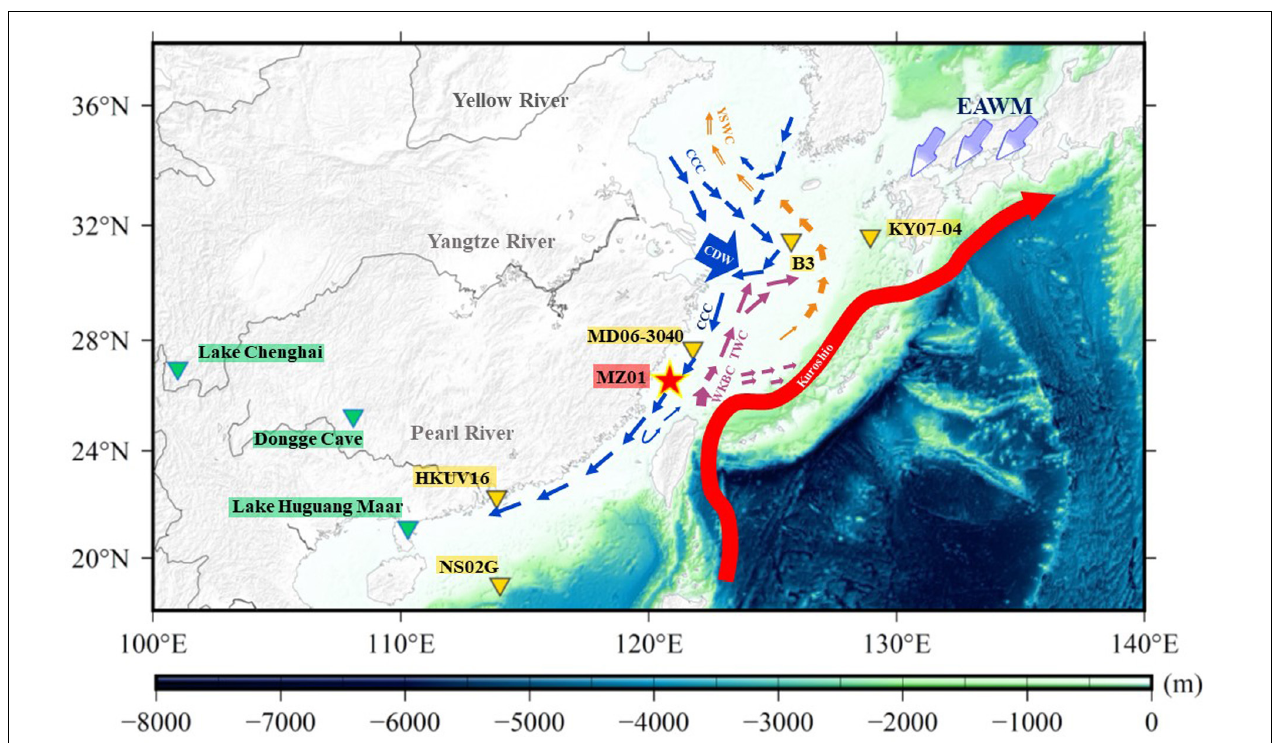
FIGURE 1 | Topography of the study area close to site MZ01 (red star) and the fluvial systems on surrounding continents. Also shown are locations of oceanic archive KY07-04 (Nakanishi et al., 2012), B3 (Zhao et al., 2014), MD063040 (Wang et al., 2014), HKUV16 (Kong et al., 2014), NS02G (Kong et al., 2014) labeled with yellow triangles; and terrestrial archives Dongge Cave (Dykoski et al., 2005), Lake Huguang Maar (Yancheva et al., 2007), and Lake Chenghai (Xu et al., 2020) labeled with green triangles. The arrows show monsoon winds and current systems: Kuroshio Current, Western Kuroshio Branch Current (WKBC), Taiwan Warm Current (TWC), and Changjiang Diluted Water (CDW) after Lie and Cho (2016); Chinese Coastal Current (CCC) after Lee and Chao (2003); and Yellow Sea Warm Current (YSWC) after Bian et al.